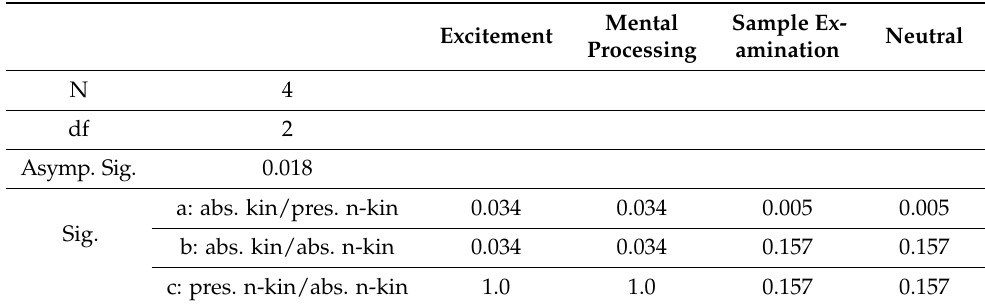
Table 4. Corresponding statistics after Friedman tests and post hoc tests.